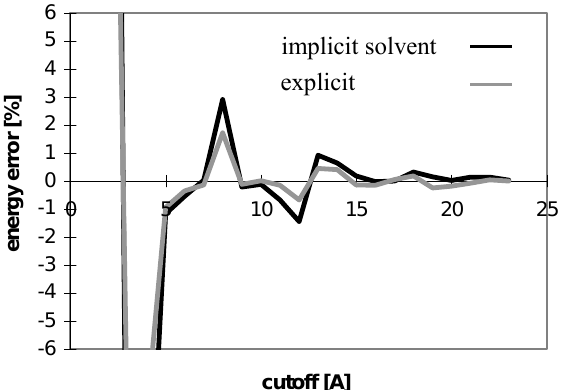
Figure 14. Dependency of electrostatic energy (calculated using cutoff method) on cutoff for implicit solvent and explicit solvent (without including solvent-solvent interactions) for nucleotide sugar